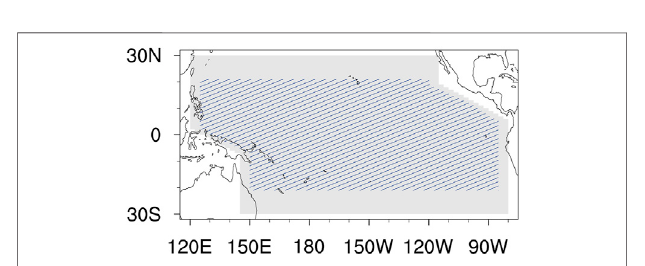
FIGURE3| Spatialdomainfortheoceandynamicsmodel(grayshading) and mixed layer model (blue hatching) of RCZ.